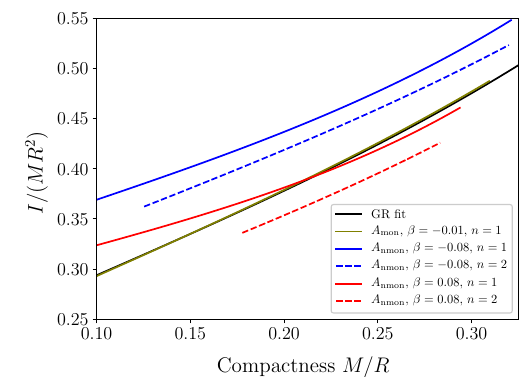
Fig. 5 Comparison between the ˜ I fits obtained through (28) for differ- ent theory parameters considered. The olive curve is that obtained for the monotonic coupling function (12) while the remaining four curves show the qualitative difference in results for positive and negative beta in the case of non-monotonic coupling (11)